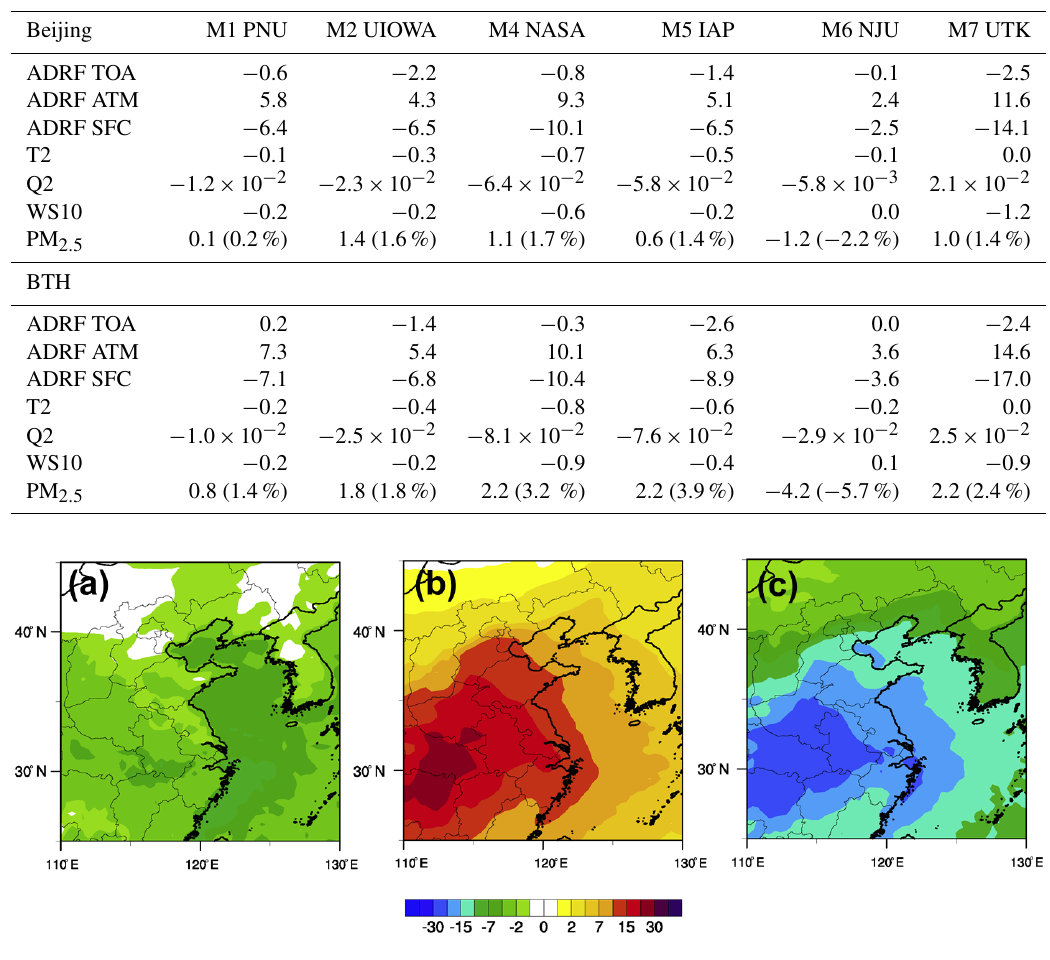
Figure 2. Ensemble mean of monthly (January 2010) mean aerosol direct radiative forcing at the top of the atmosphere (a) , inside the atmosphere (b) , and at the surface (c) .